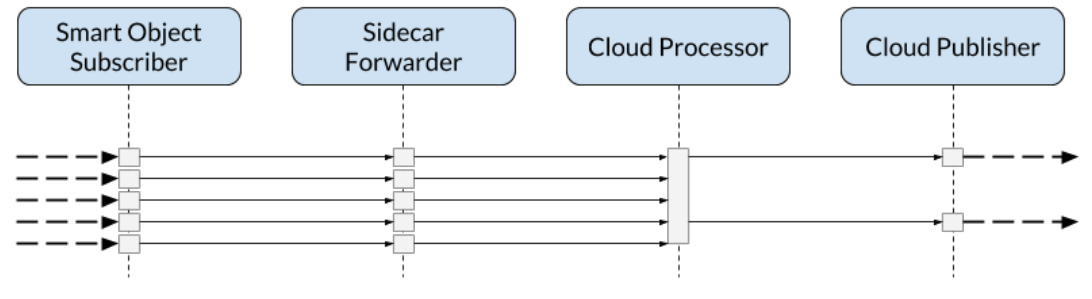
Figure 5. Data messages handling with intermediate processing.